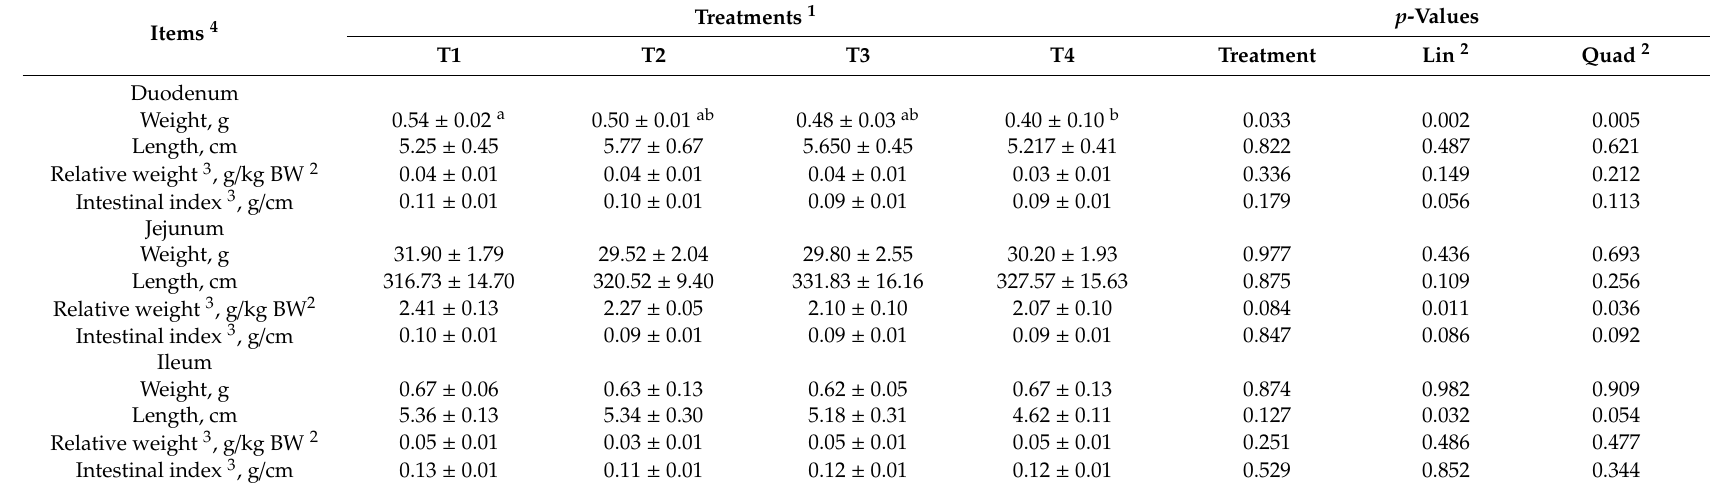
Table 6. E ff ects of the ratio of insoluble to soluble fiber in sow gestation diets on the intestinal development of neonatal piglets.